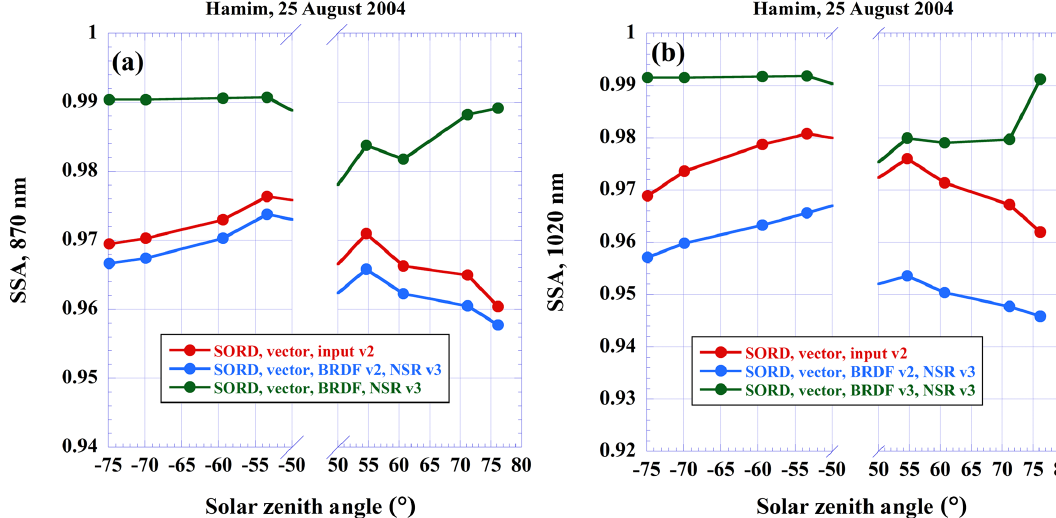
Figure 10. The same as Fig. 9 but for (a) 870 and (b) 1020nm.